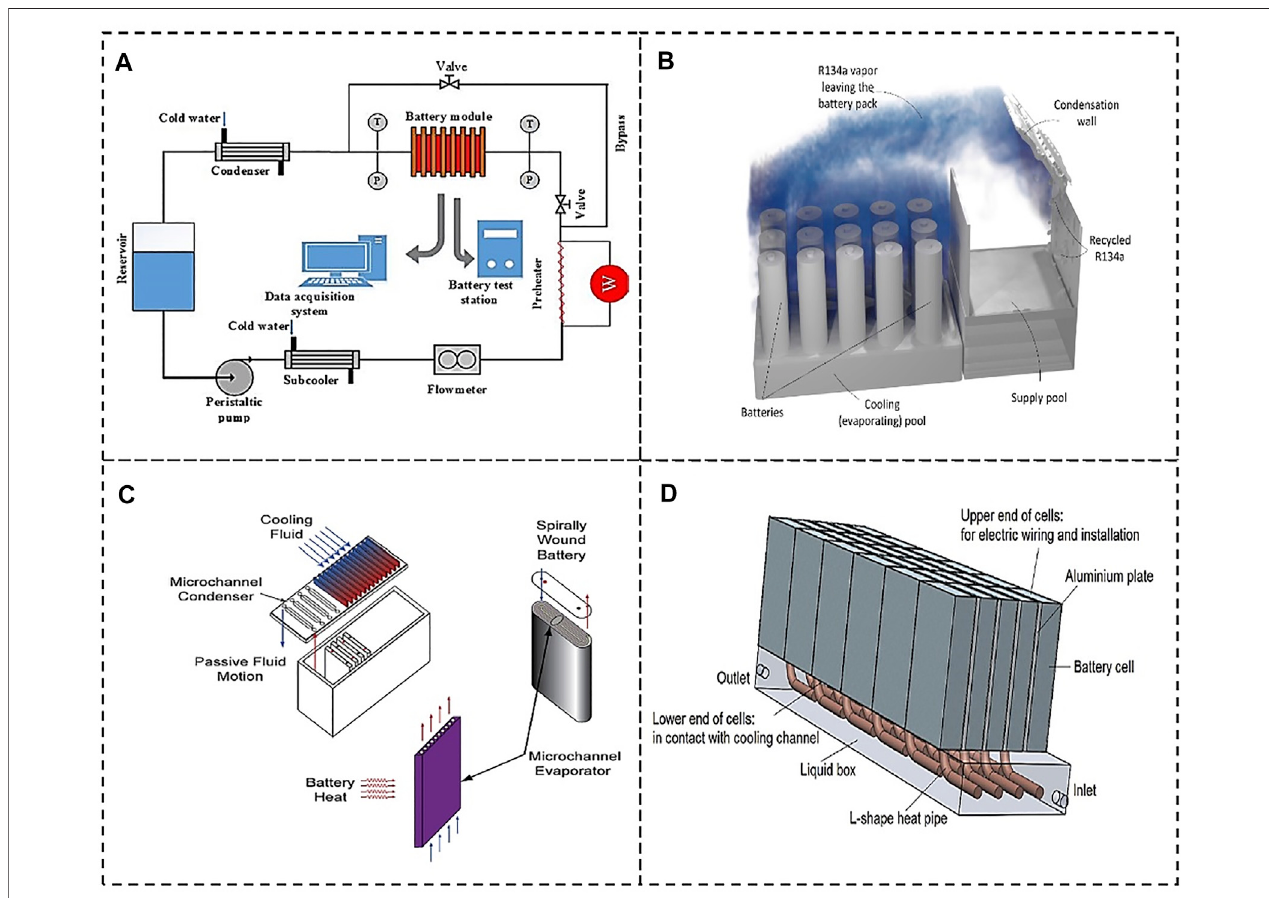
FIGURE 7 | Liquid-gas cooling system. (A) Boiling cooling based mini-channel. Reproduced with permission (Zou et al., 2018). Copyright 2017, Elsevier. (B) Liquid-vapor phase-change cooling. Reproduced with permission (Al-Zareer et al., 2020). Copyright 2020, Elsevier. (C) Liquid-vapor BTMS based on microchannels. Reproduced with permission (Bandhauer and Garimella, 2013). Copyright 2013, Elsevier. (D) BTMS combined HP. Reproduced with permission (Wang et al., 2014). Copyright 2014, Elsevier.